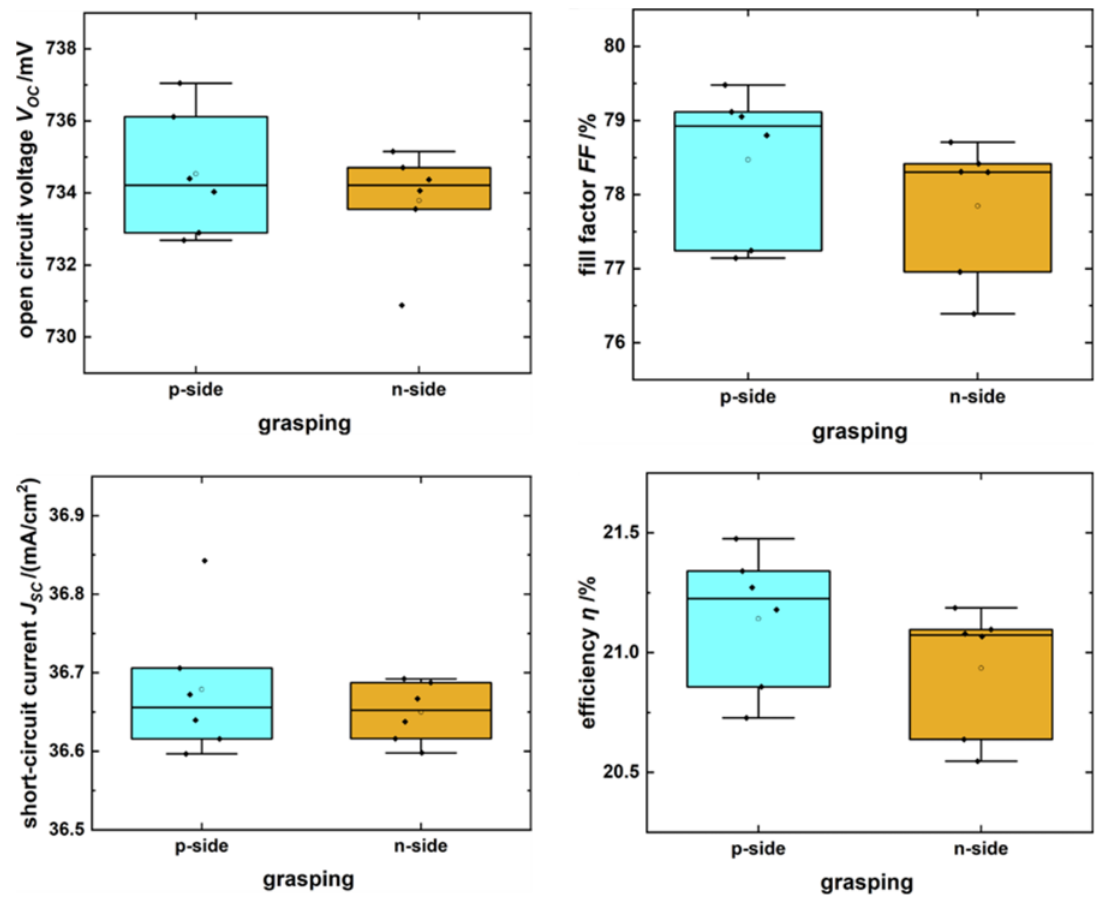
Fig. 6. Results for cell parameters of cells handled before passivation on the later emitter or non-emitter